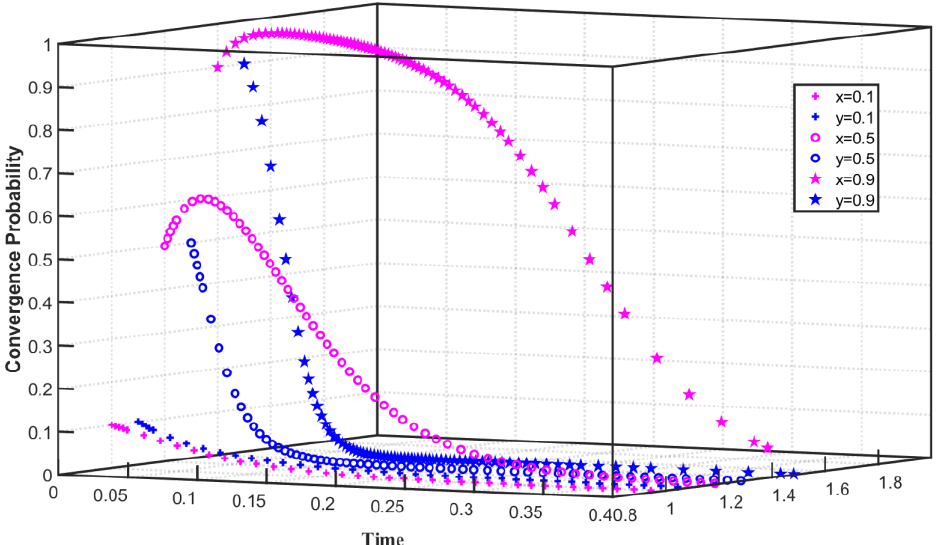
Figure 1. Evolution path of two-party game system under high emission reduction cost and high regulation cost.